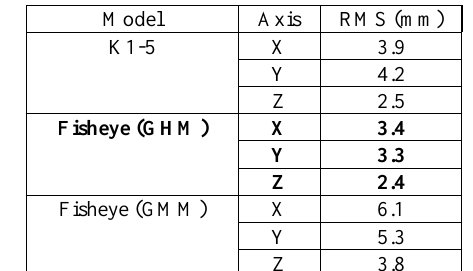
Table 3. RMS of object-space coordinate differences of checkpoints for the Ladybug5 camera in check adjustment using parameters estimated from various